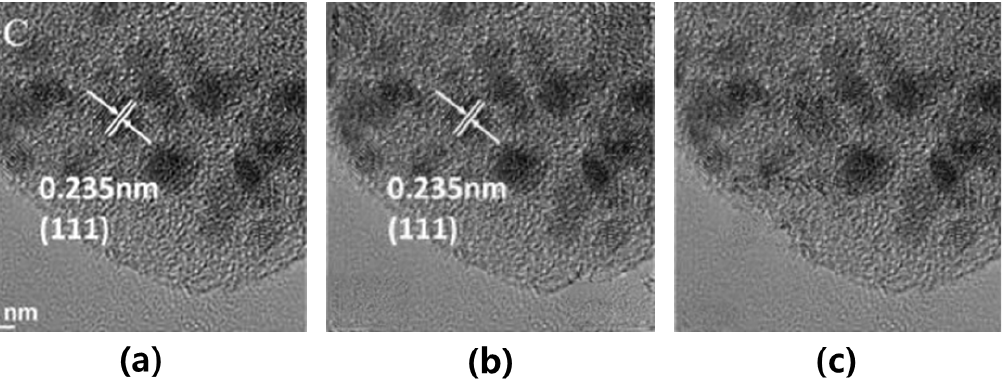
Figure 5. Comparison of the results, which was achieved by using a statistical mask and a threshold mask from the example of microscopic image (reprinted with permission from Ref. [41]. Copyright (2019) Elsevier): ( a ) represents input image; ( b ) represents output image using a statistical mask; and ( c ) represents the output image when using a threshold-based